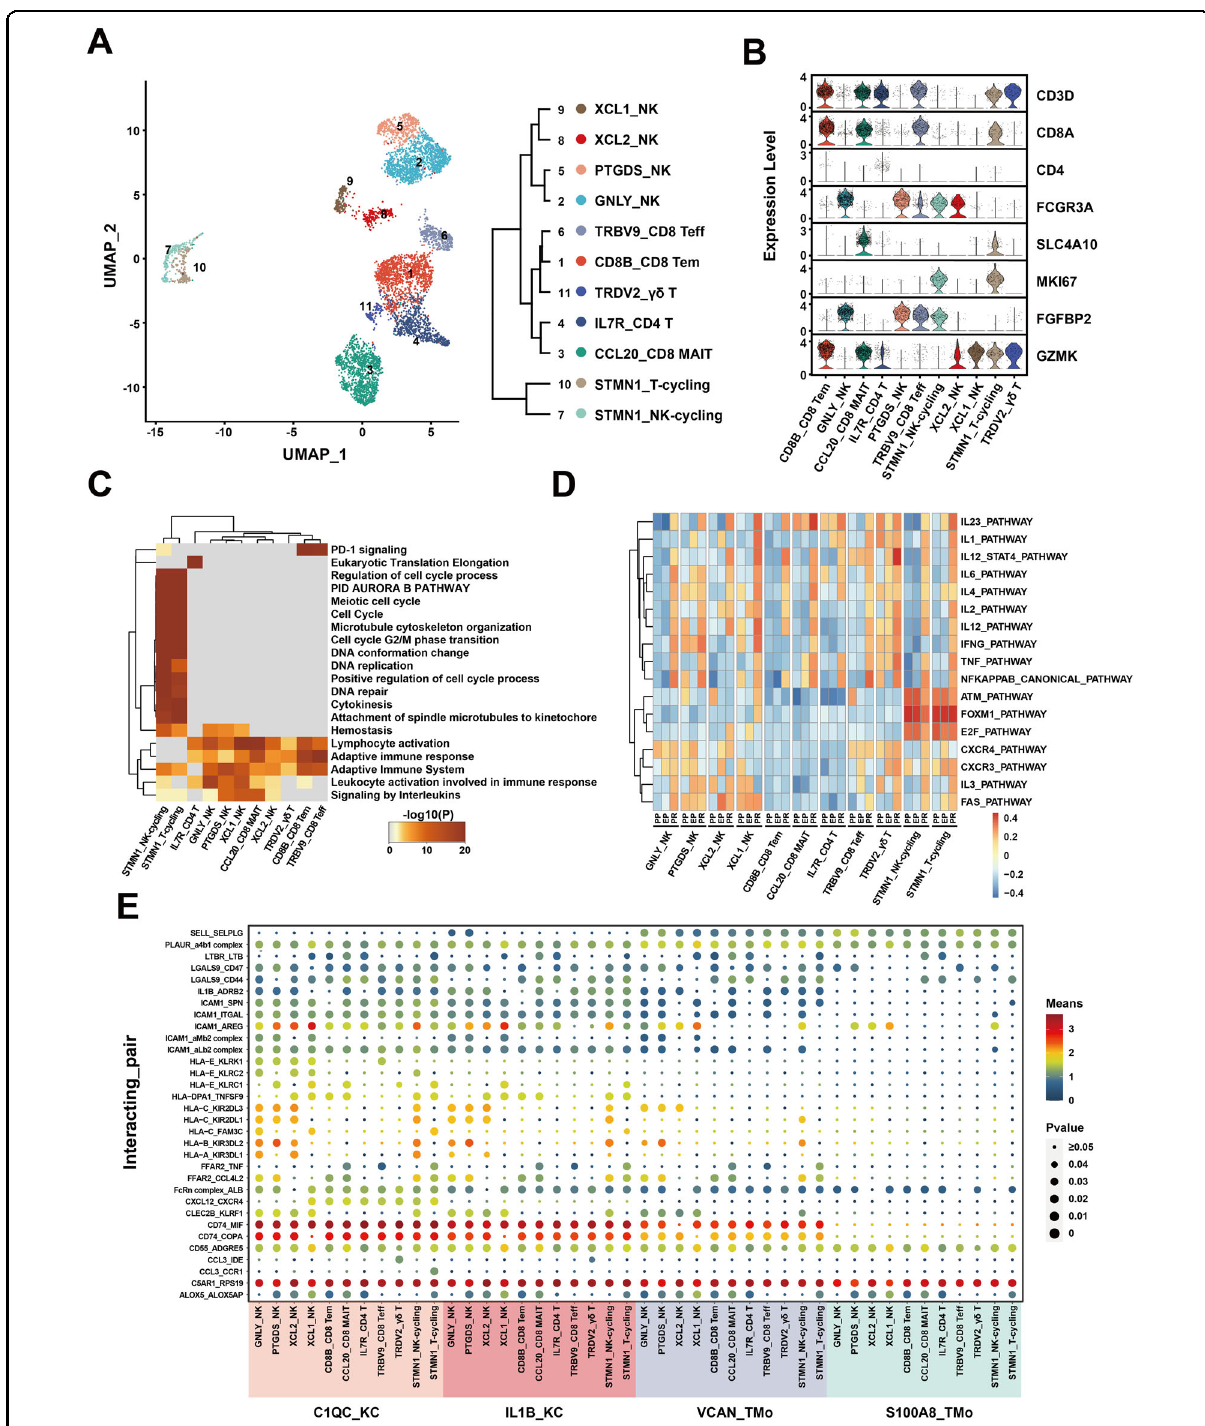
Fig. 5 scRNA-seq of NK/T cells in liver transplantation. A UMAP plot showing 11 NK/T cell clusters in liver transplantation, colored according to different clusters (left panel). Dendrogram of 11 clusters by the hierarchical clustering analysis based on their normalized mean expression values (right panel). B Violin plots showing the normalized expression of marker genes ( y -axis) for NK/T cell clusters ( x -axis). C Gene Ontology enrichment analysis results of NK/T cell clusters. Only the top 20 most signi fi cant GO terms ( p value < 0.05) are shown in rows. D GSVA showing the pathways (PID gene sets) with signi fi cantly different activation in different samples of NK/T cell clusters. Different colors represent different activation scores. E Cell – cell interaction analysis between mononuclear phagocyte clusters and different NK/T cell clusters in PR samples. Ligand – receptor pairs labeled in y -axis. The size of the circle represents the level of p value, and different colors represent different means values. Ligands come from mononuclear phagocyte clusters, and receptors come from NK/T cell clusters. Of fi cial journal of the Cell Death Differentiation